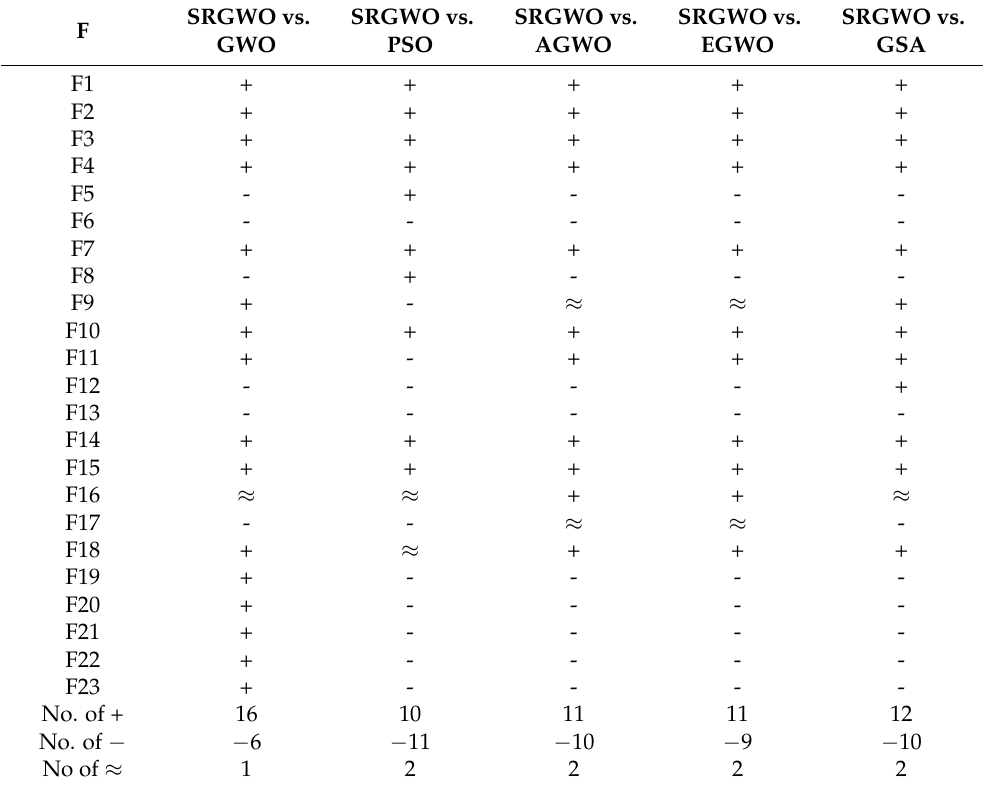
Table 4. Non-parametric sign test